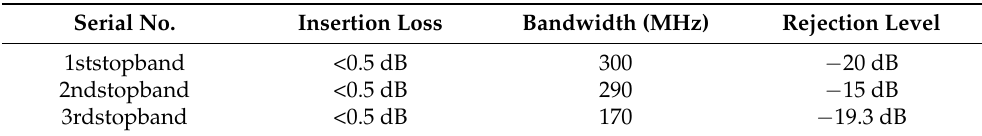
Figure 17. Validation of all bands w.r.t L 8 . Table 3. Calculated properties of the stopbands. Serial No.